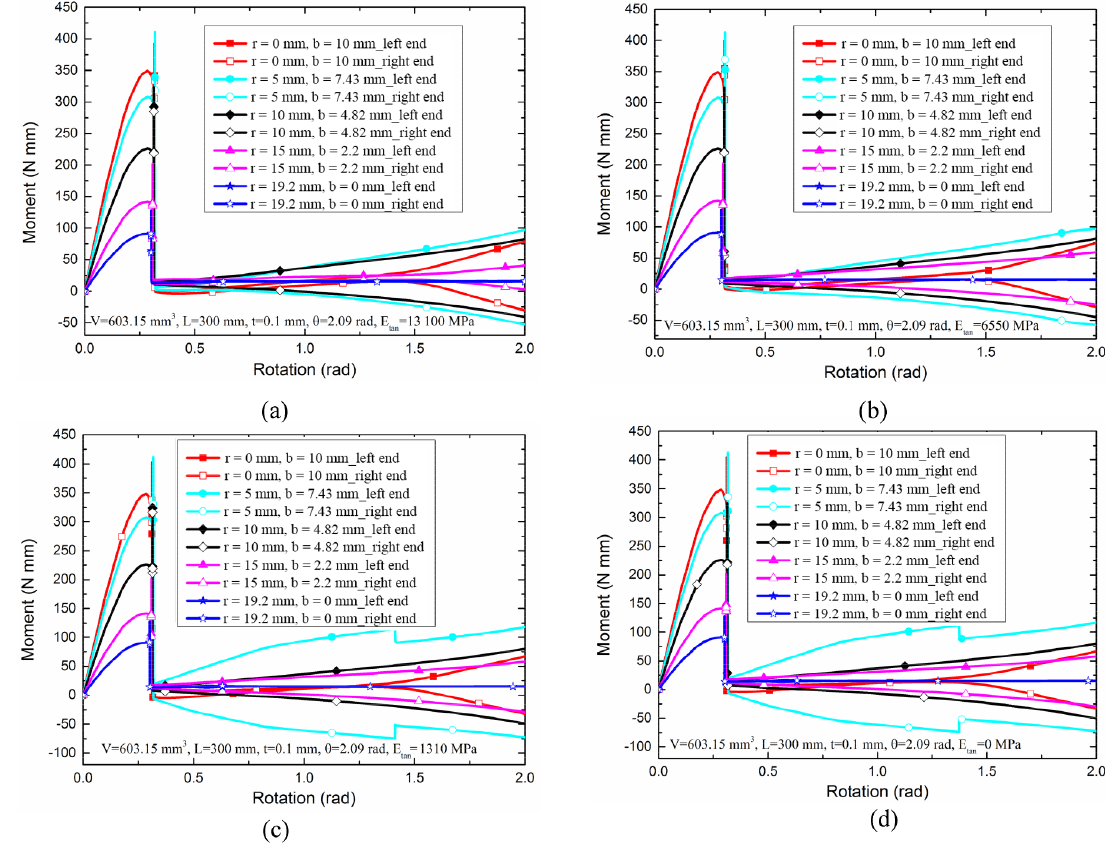
Figure 12. Moment-rotation curves obtained from finite element modelling by using bilinear material model with different tangent modu- lus (a) E tan = 13100MPa, (b) E tan = 6550MPa, (c) E tan = 1310MPa, and (d) E tan = 0MPa (elastic-perfectly plastic